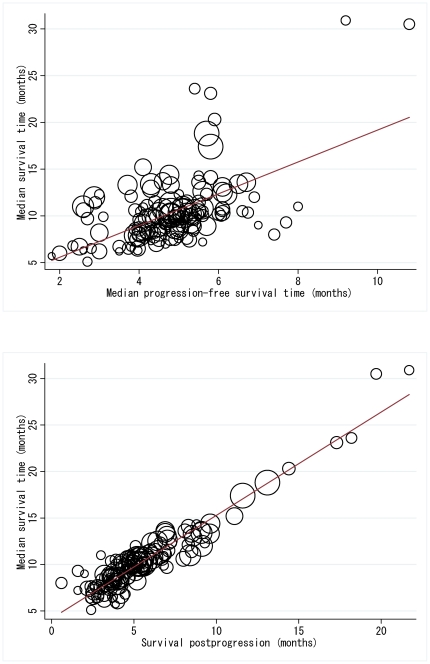
Overall survival, progression-free survival and survival post-progression.A. Associations between median survival time and median progression-free survival time (r
2 = 0.2563). B. Associations between median survival time and survival post-progression (r
2 = 0.8917). All analyses were weighted by trial size.